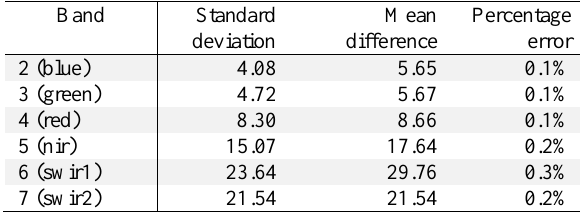
Table 4. Difference between TOA reflectance values (scaled to 10000) of a real-time product and a LPGS reference image